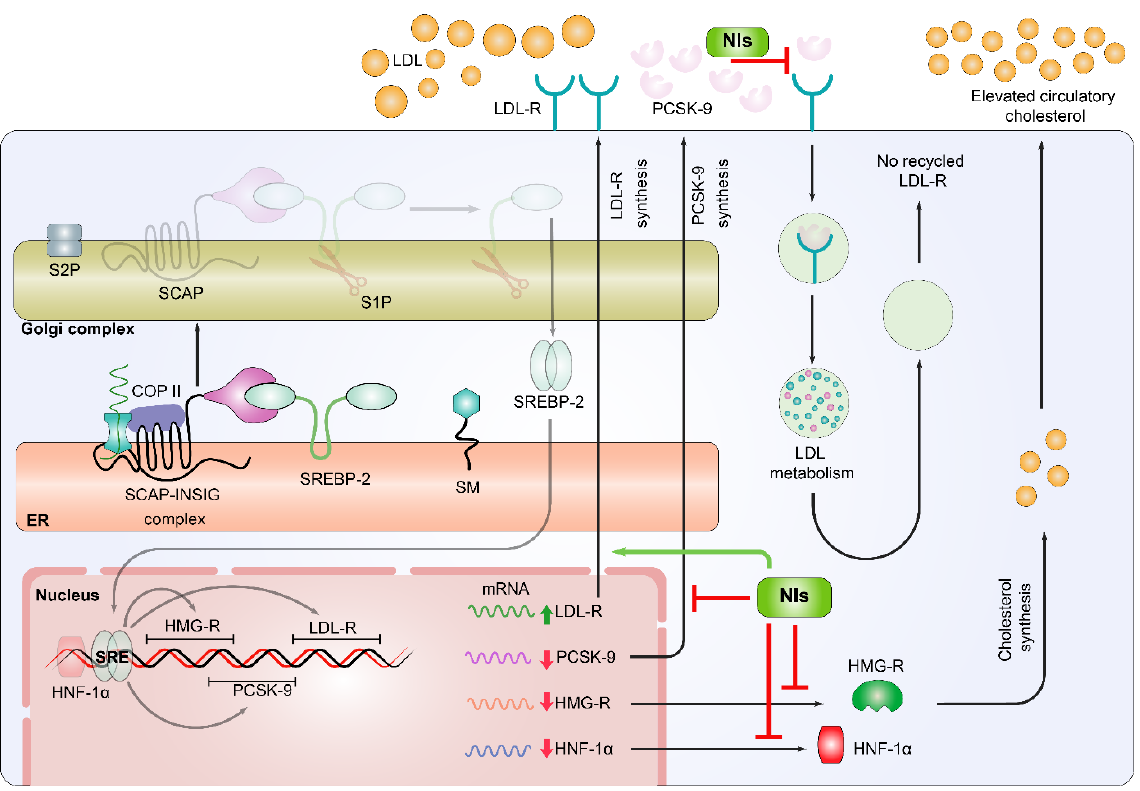
Figure 3: Potential mechanisms of inhibition of PCSK-9 and HMG-R via natural inhibitors (NIs). Natural compounds adopt distinct mechanisms to maintain the cholesterol biosynthesis and to prevent the ath- erosclerosis. These mechanisms are: Natural compounds are involved in the up-regulation of LDL-R mRNA expression and down-regulation of PCSK-9, HMG-R, and HNF-1α expression. Level of LDL-R protein is enhanced on the surface of hepatocytes and hence the recycling of LDL-R is also stimulated. The implication of NIs enhanced the LDL-C clearance through LDL-R and also restricted the interaction between PCSK-9 and